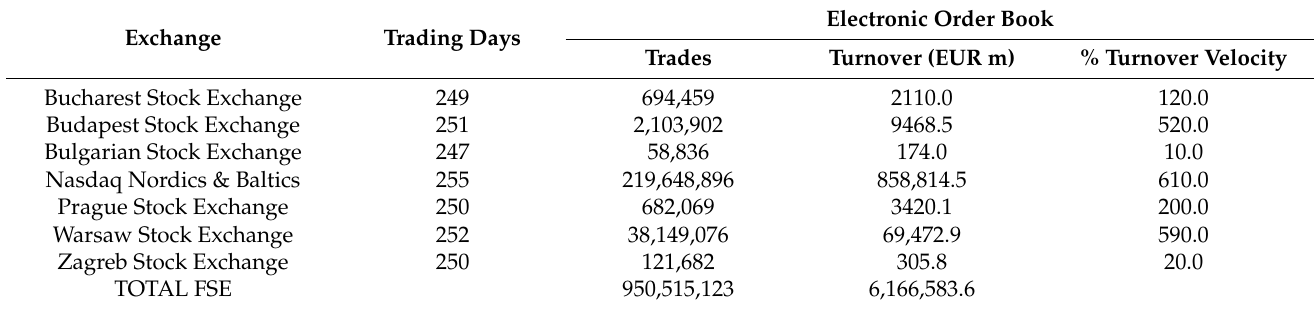
Table 1. Domestic equity trading.